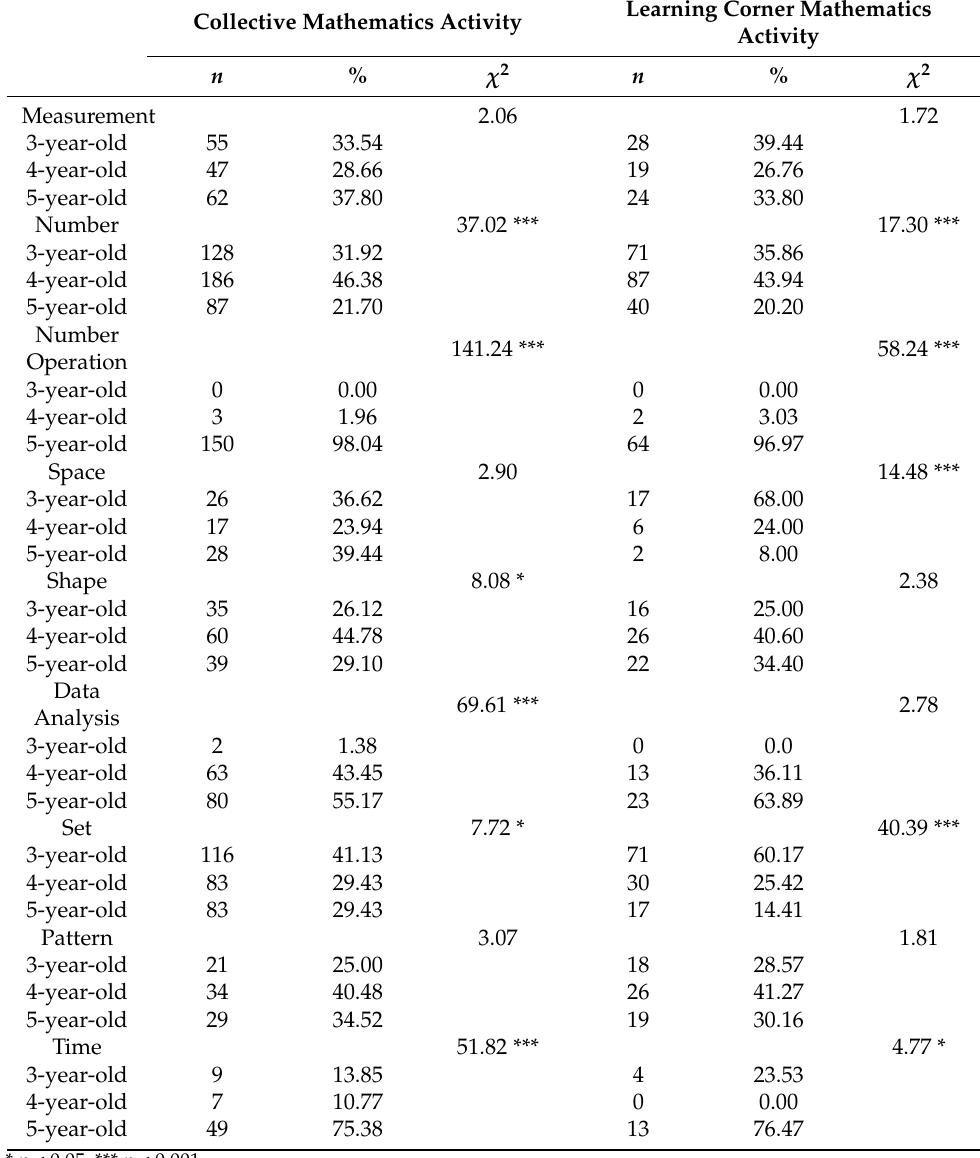
Table 3. The distribution of different mathematical concepts across all age